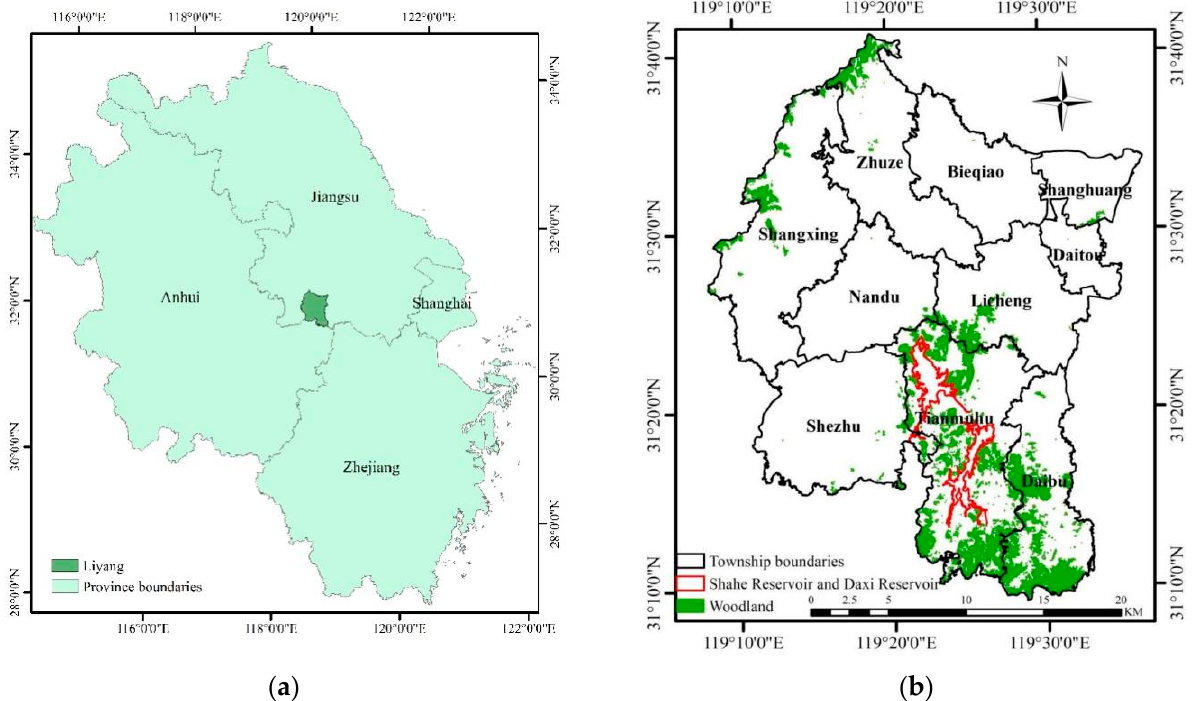
Figure 1. Overview of the study area. ( a ) Geographical location of the study area. ( b ) Spatial distribution of woodland in Liyang. Smaller black areas are named townships. Smaller red areas are named reservoirs.